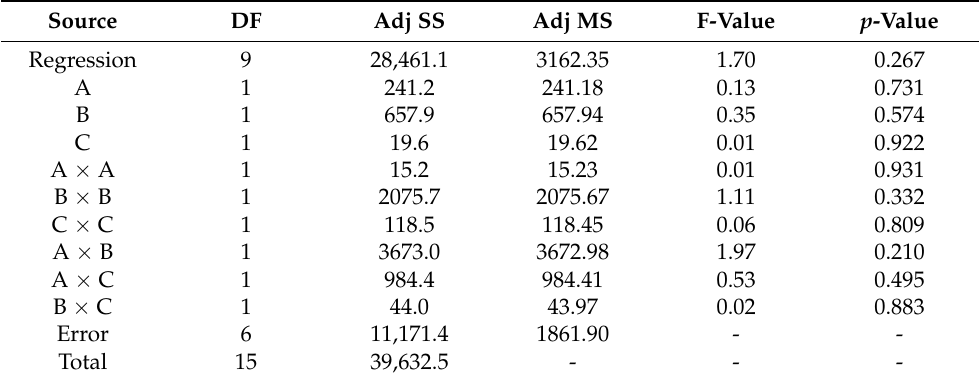
Table 6. ANOVA results obtained for corresponding MRR values. Degree of freedom (DF). Sum of the Squares (SS). Mean of the Squares